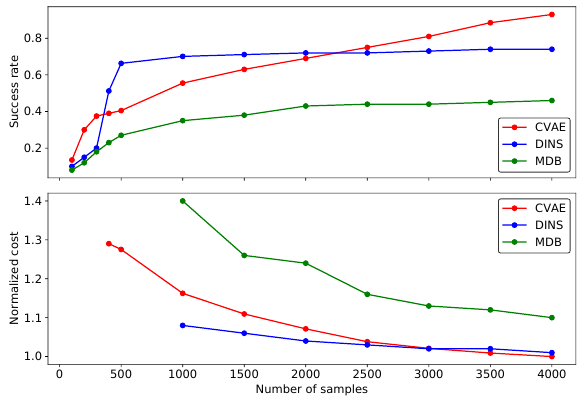
Figure 5: Comparison of the convergence rate in the Mansund